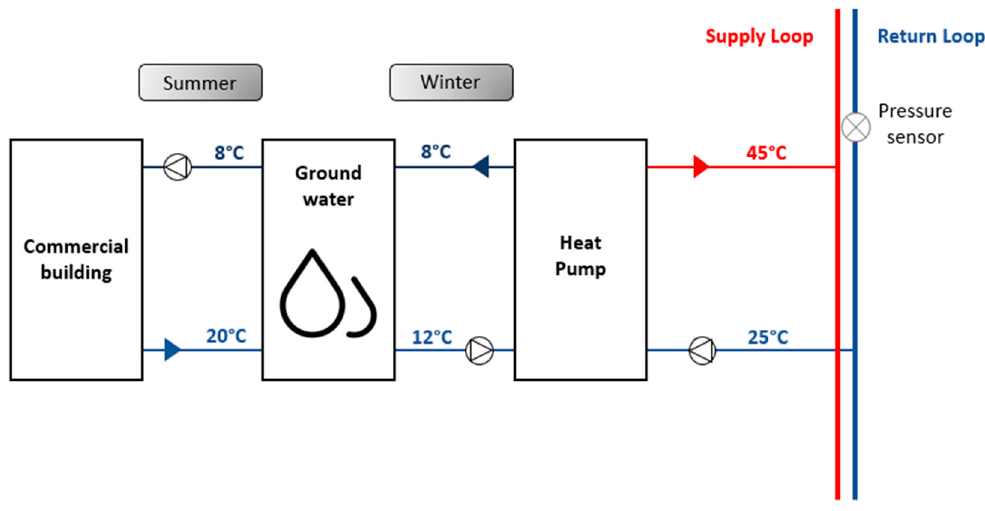
Figure 4. Schematics of the connection of groundwater heating and cooling system to the double loop network.